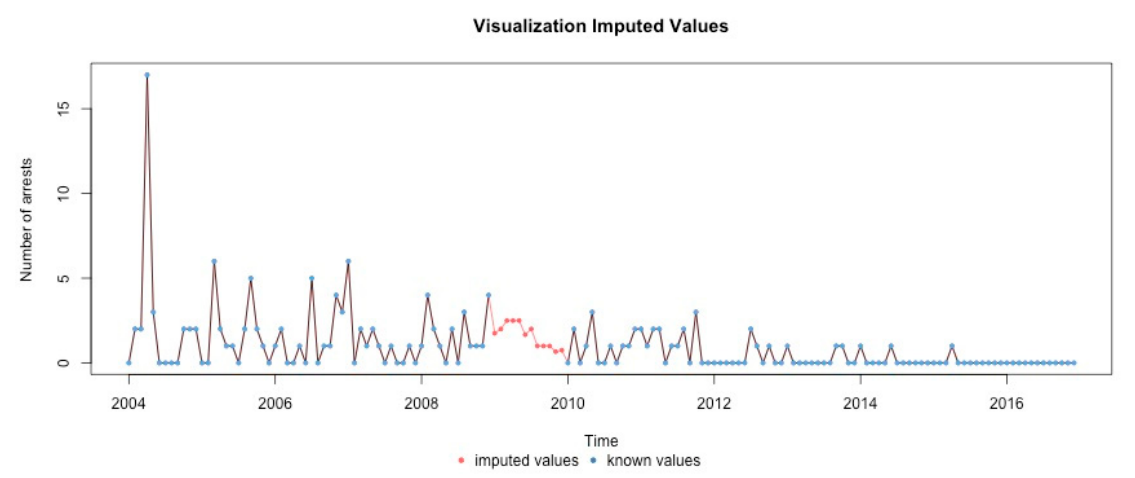
Figure A19. Heroin Vietnam nationals arrests 2004–2016 in the Czech Republic – imputed missing values.